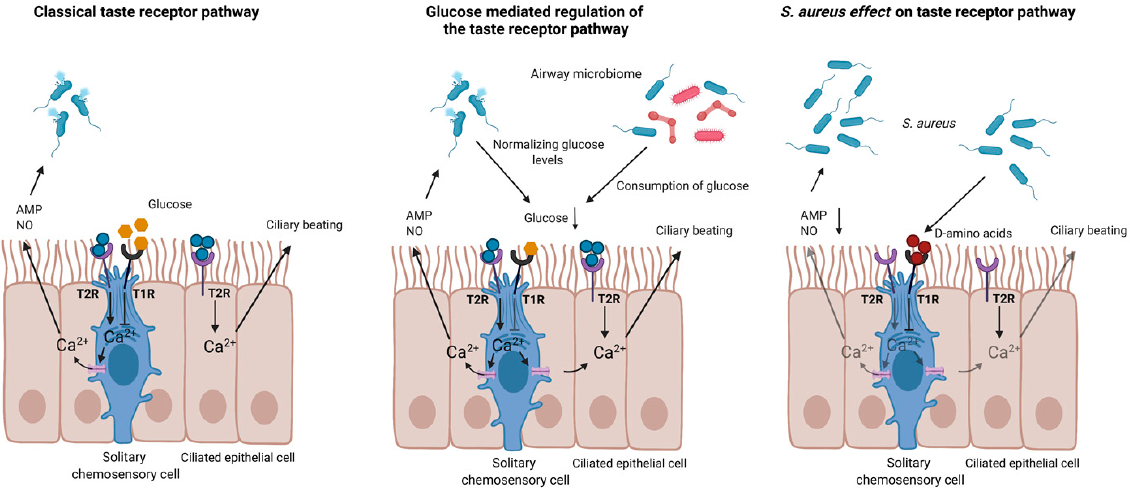
Figure 1. The role of taste receptors in the upper airways. T2Rs are expressed on ciliated airway epithelial cells and solitary chemosensory cells (SCCs). Activation of T2R on SCCs rapidly increases calcium release. Via gap junctions, surrounding epithelial cells are then stimulated to release antimicrobial compounds of T2R on ciliated airway epithelial cells, resulting in an immediate calcium-dependent increase in the production of nitric oxide (NO). NO will increase ciliary beating and kill bacteria. The activation of T2R is counterbalanced by the activation of T1R in SCCs. T1Rs are activated by sweet compounds such as glucose (classical taste receptor pathway). It is hypothesized that consumption of glucose by bacteria causes a favorable balance for T2R stimulation with subsequent activation of local defenses against the invading pathogen, resulting in decreased microbial numbers and restoration of the glucose concentrations (glucose mediated regulation of the taste receptor pathway). However, S. aureus can produce bacterial ligands such as the D-amino acids, which can activate T1Rs. The activation of T1R by these ligands blocks T2R mediated release of NO and AMP and as such, prevents killing of S. aureus ( S. aureus effect on taste receptor pathway). T2R = bitter taste receptor; T1R = sweet taste receptor; NO = nitric oxide; AMP = antimicrobial peptide; Ca 2+ = calcium. Created with